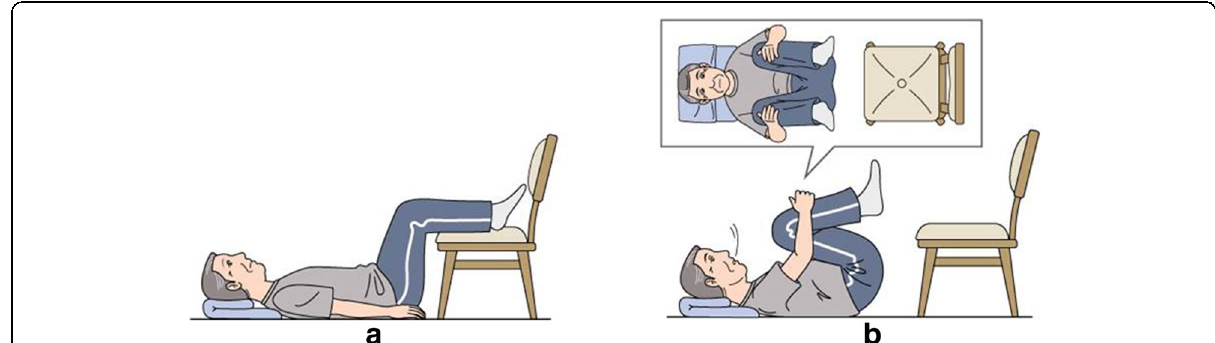
Fig. 1 Schema of the exercise. a : Lie on your back and put your feet on the chair so that the hip joint and knee are at right angles. b : Holding your breath while holding down the knees, slowly count five. On the way, if you get tired, put your feet on the chair and